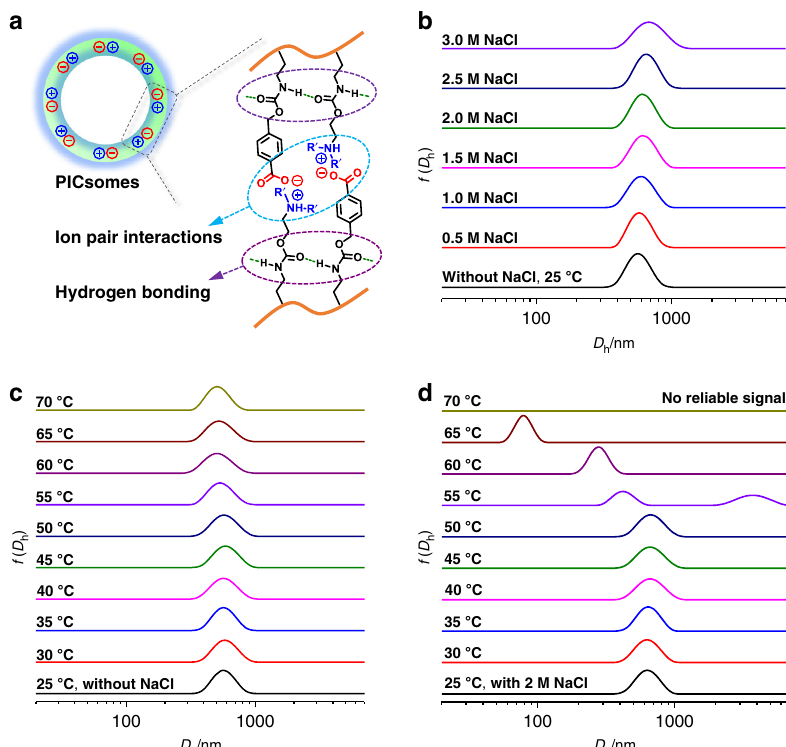
Fig. 7 PICsome nanostructures stabilized by multiple and cooperative noncovalent interactions. a Microstructural stability of PICsomes contributing from multivalent ion-pair, hydrogen bonding, and π – π interactions at high local concentration due to the pre-organized nature of vesicle bilayers. b – d Intensity-average D h distributions recorded for the aqueous dispersion of PICsomes (fabricated from PEO 45 - b -P(NCMA 0.55 - co -DPA 0.45 ) 29 polymersomes via UV irradiation for 10 min) at varying temperatures, ionic strengths, and combinations of them. All data were obtained at a polymer concentration of 0.1 g/L with [NCMA] ~ 0.12 mM and [DPA] ~ 0.10 mM in neutral aqueous